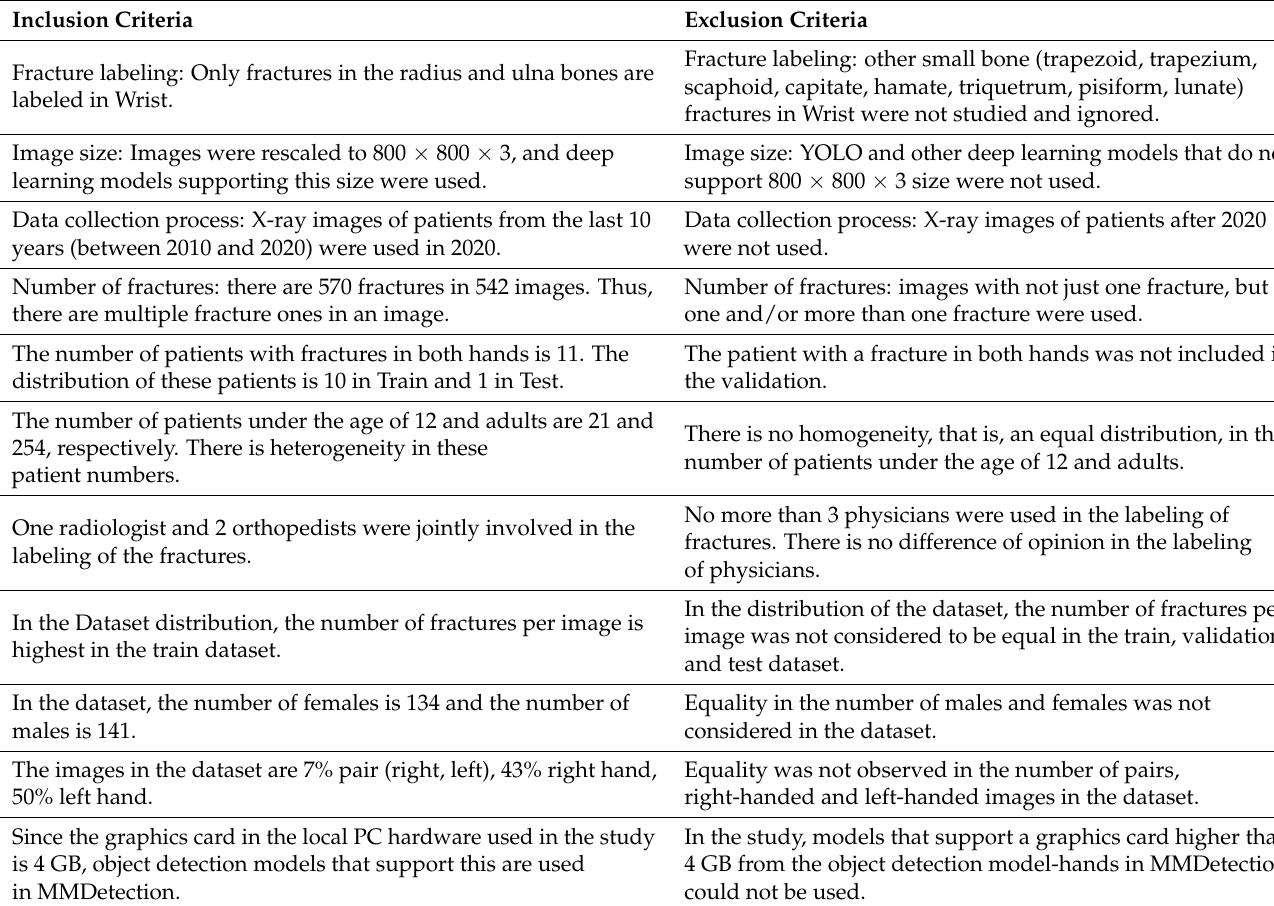
Table 12. Inclusion/exclusion criteria for